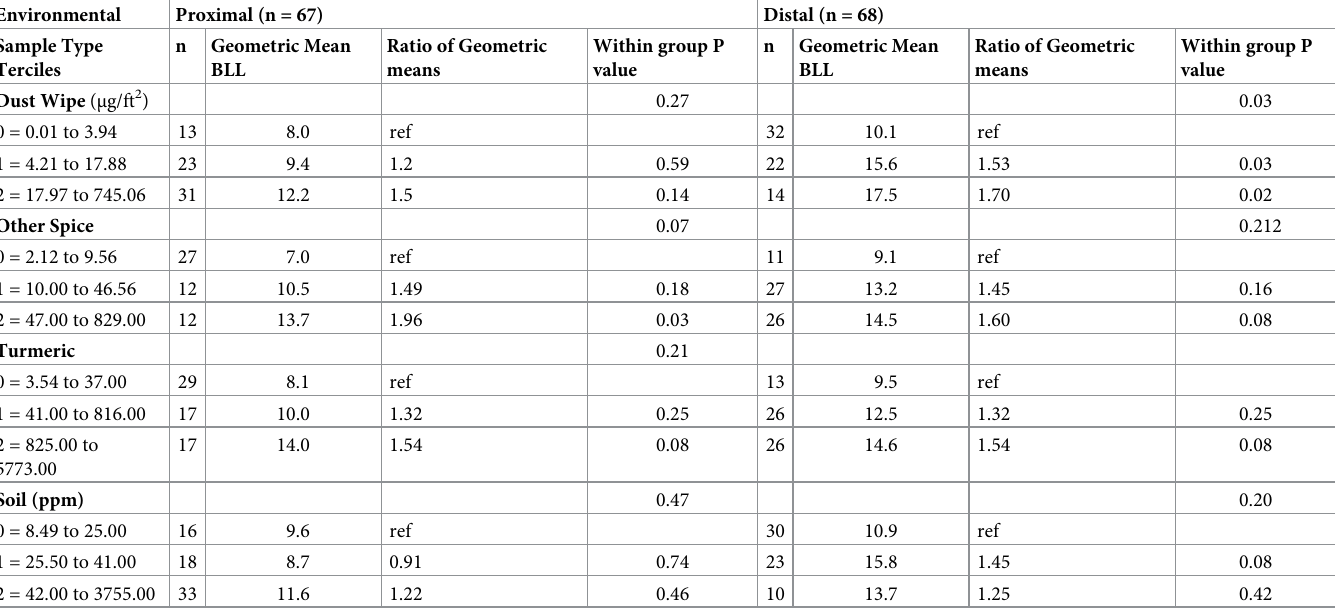
Comparing the GM BLL for Proximal children to lead concentrations in environmental media, BLL in the third vs. first tercile are significantly higher for other spice. For Distal children BLL in the third vs. first tercile are significantly different for lead levels in dust wipe. For both groups the ratio of GM trends to higher BLL for higher lead concentrations but this difference is not significant. The difference in BLL by soil lead tercile is not